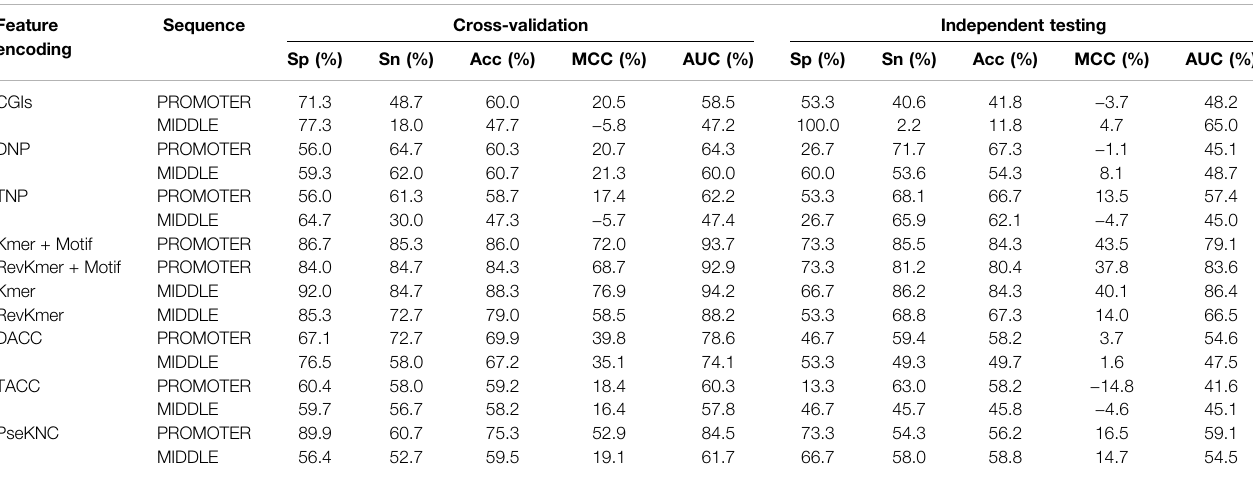
TABLE 4 | Performance of the fi rst-layer features with the SVM models. Feature